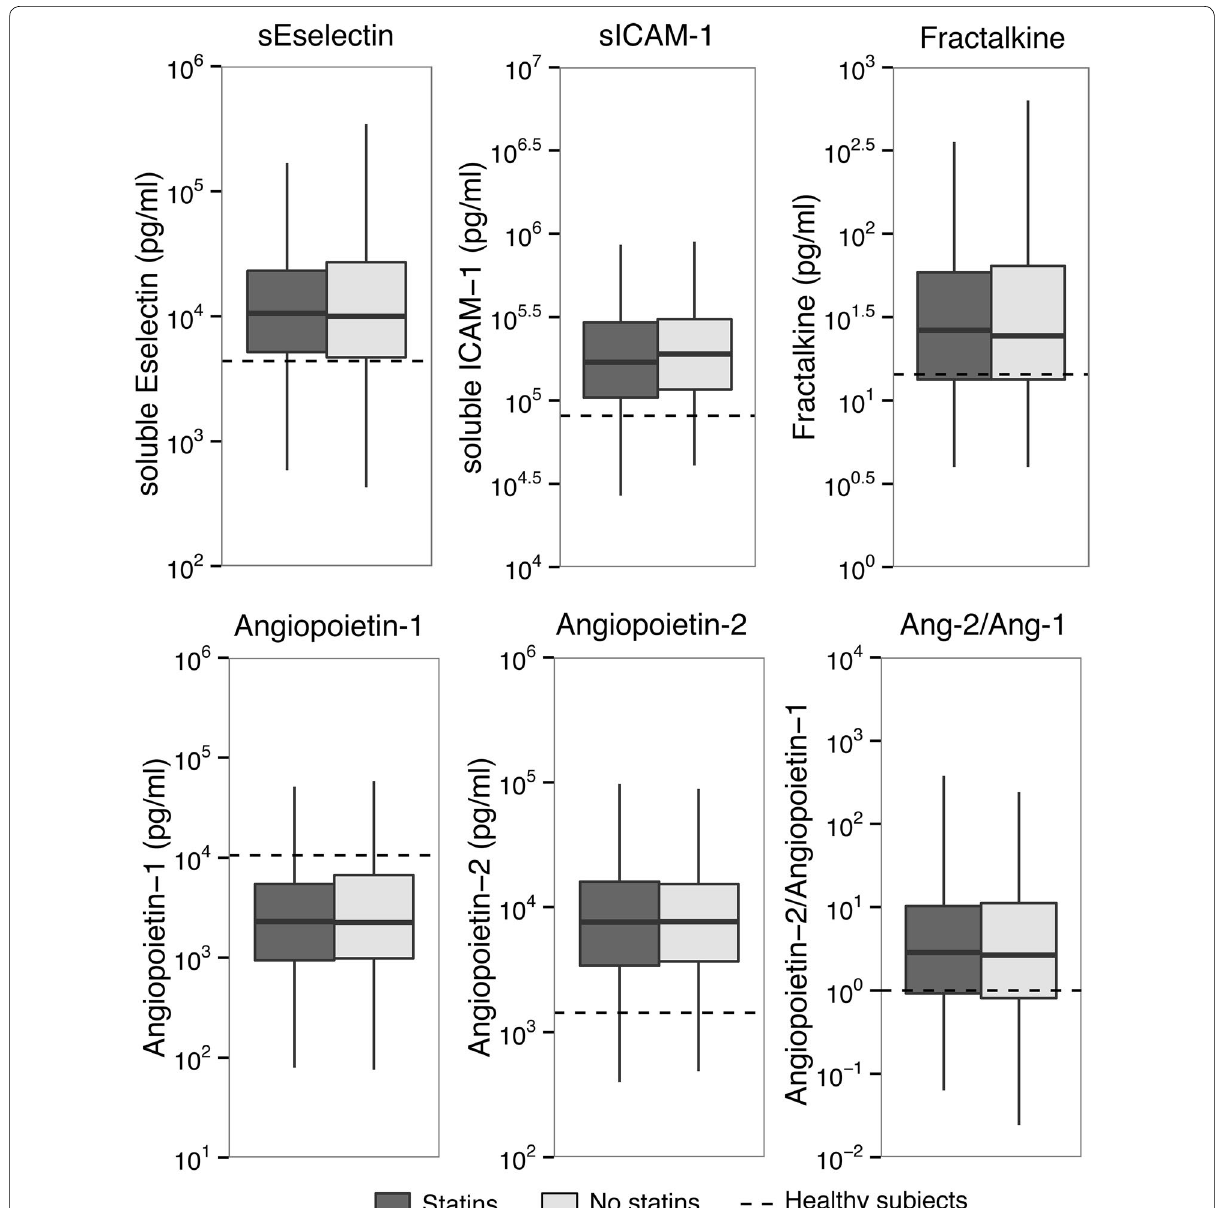
Fig. 2 Endothelial cell activation in sepsis patients on ICU admission stratified according to statin use in the propensity-matched cohort. Data are expressed as box-and-whisker diagrams depicting the median and lower quartile, upper quartile and their respective 1.5IQR as whiskers (as speci- fied by Tukey). Dashed lines represent median levels in 27 healthy volunteers. Differences between groups were not significant. ICAM-1 lular adhesion